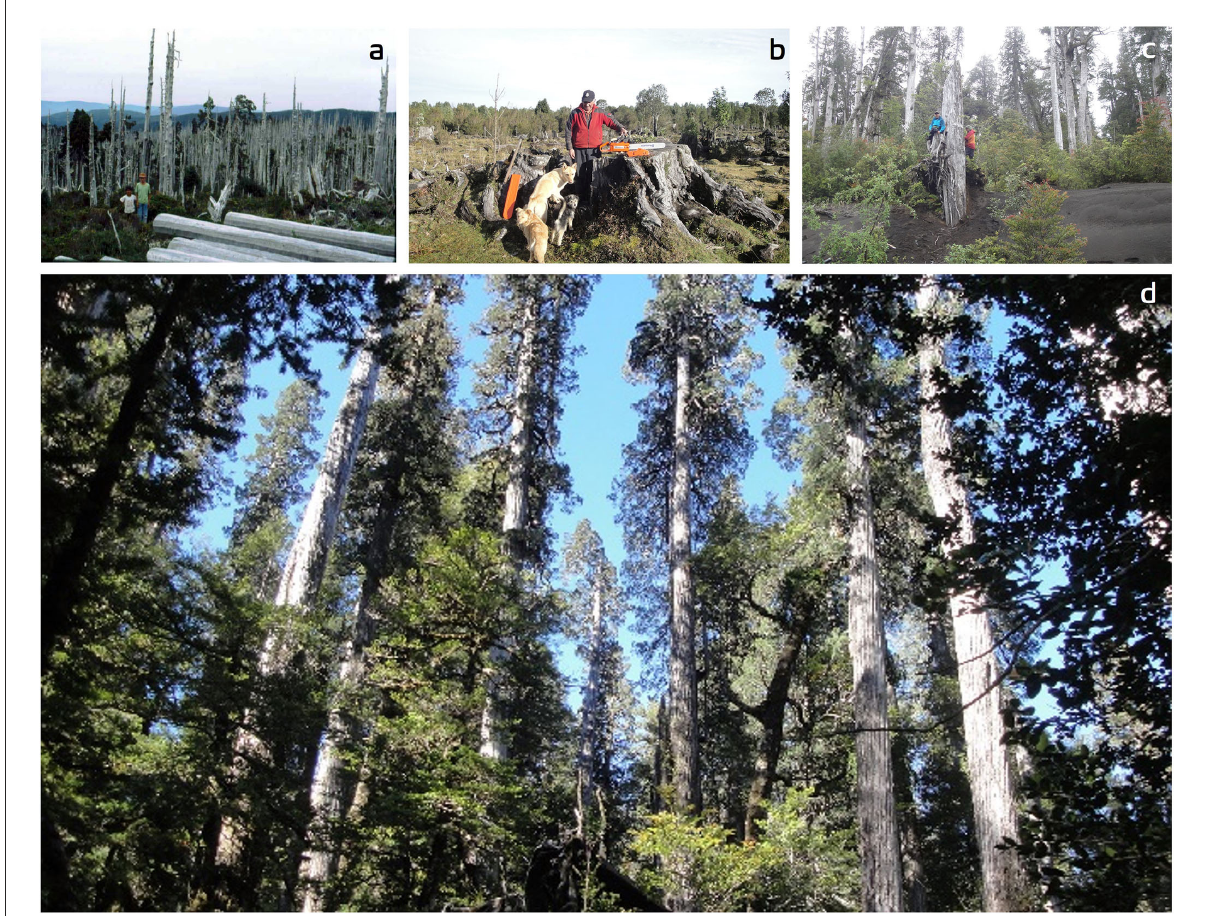
FIGURE2 Main natural and anthropogenic disturbances that shape Fitzroya cupressoides forests in the study sites. (a) Burned and logged F. cupressoides forests in the Cordillera Pelada (Coastal range). (b) Old-growth F. cupressoides forests logged at the end of the 19th century in the Central depression. Large stumps still remain due to the highly resistant, low-decaying wood, although they are currently disappearing due to their use for firewood and the production of handicrafts by local people. (c) Large snag of F. cupressoides partially buried by tephra in the Andes range (known as well trees). Trees of this diameter are commonly found completely buried as evidence of the destruction of the previous Fitzroya forest by the eruption of the volcano Apagado. (d) Old-growth forest cohort established after volcan Apagado eruption (500 BC). Photo